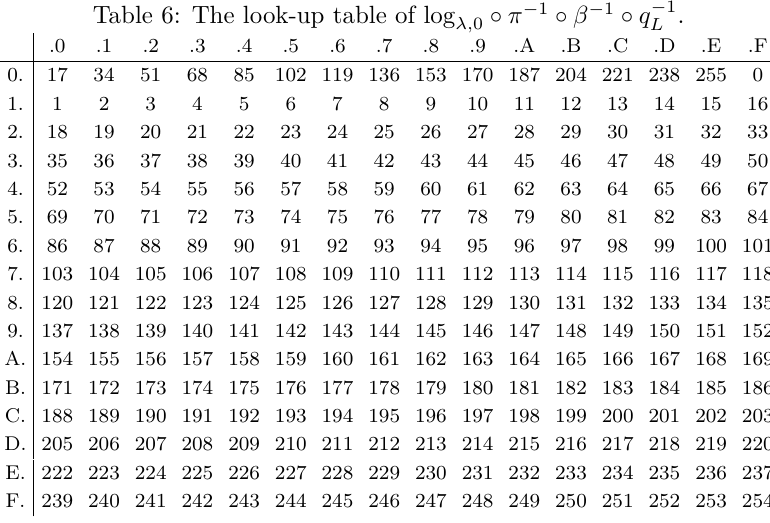
Table 6: The look-up table of log